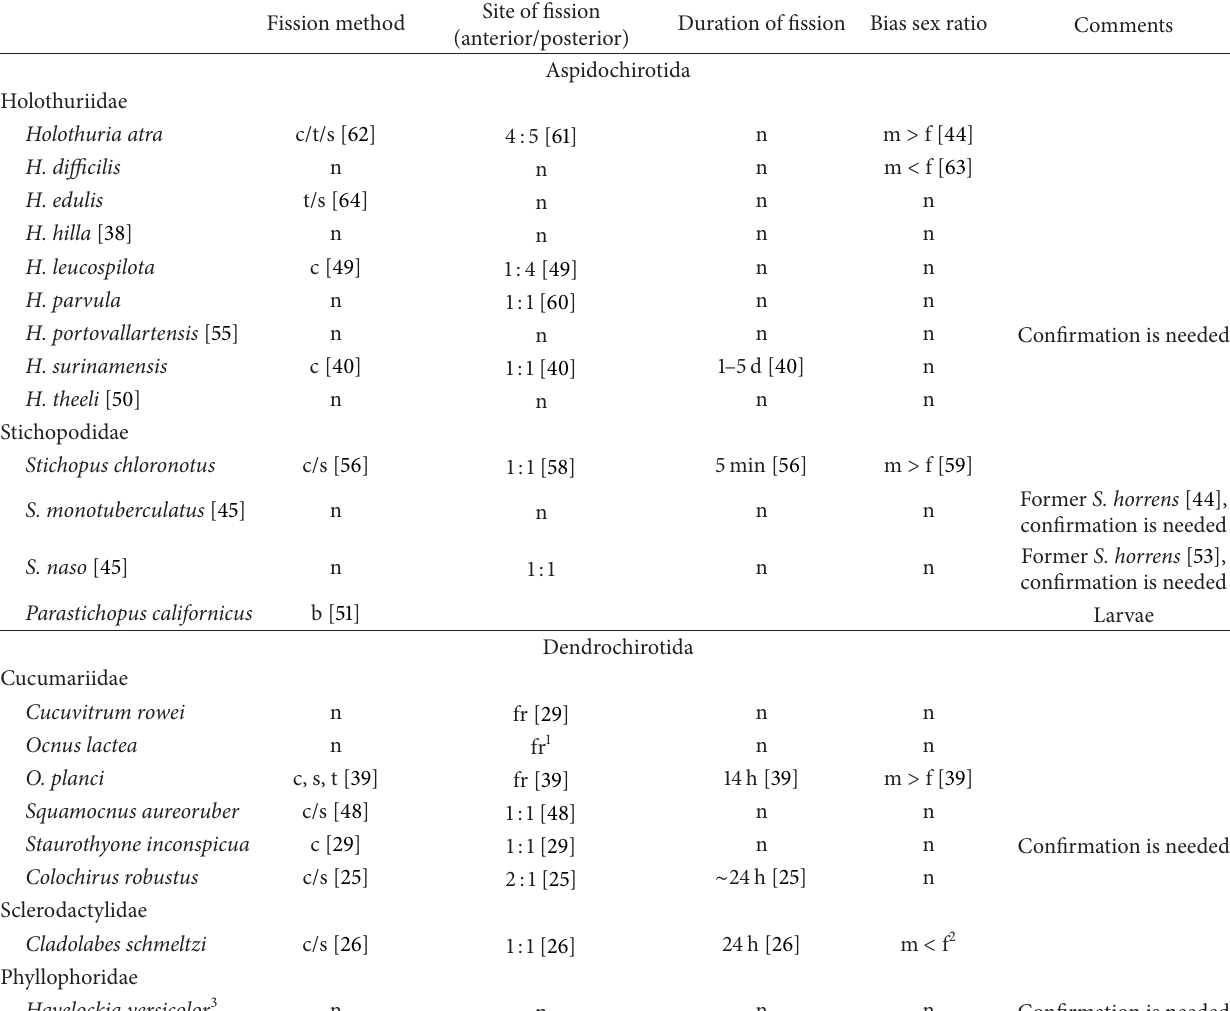
Table 1: Features of asexual reproduction in